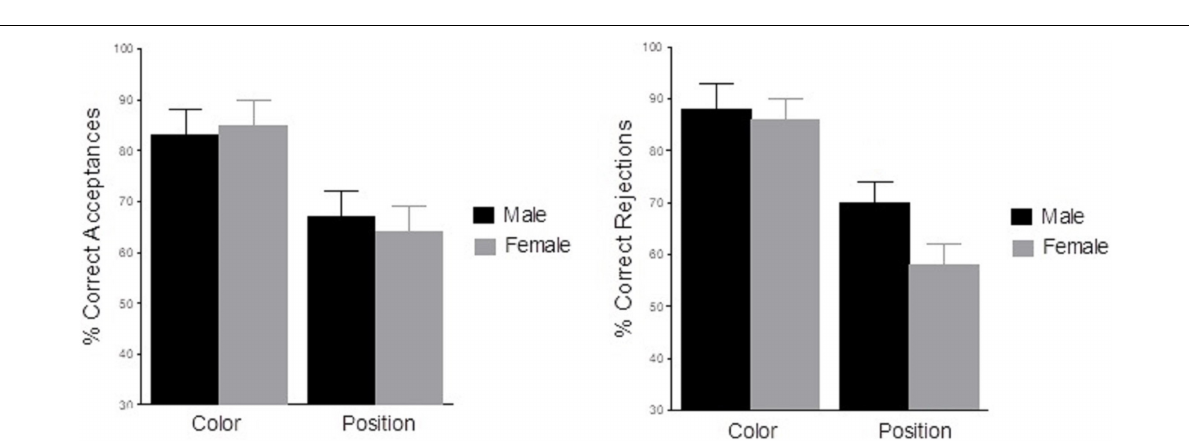
FIGURE 3 | Mean percentage of correct responses ( left graph , Hits; right graph , Correct Rejections) as a function of Criteria (Color vs. Position) and Sex (Men vs. Women). Error bars represent the standard